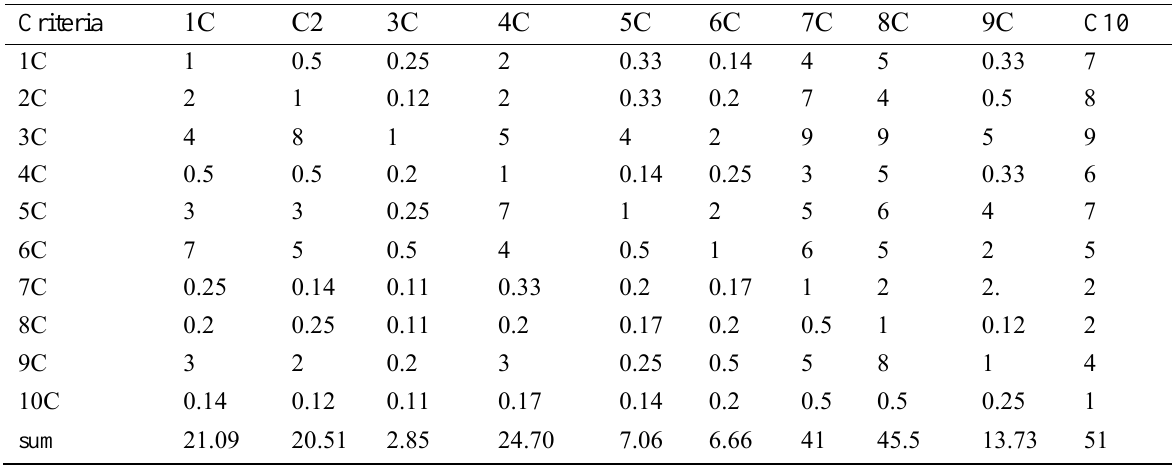
Table 3. Pairwise Comparison Matrix for Criteria with respect to Objectives.